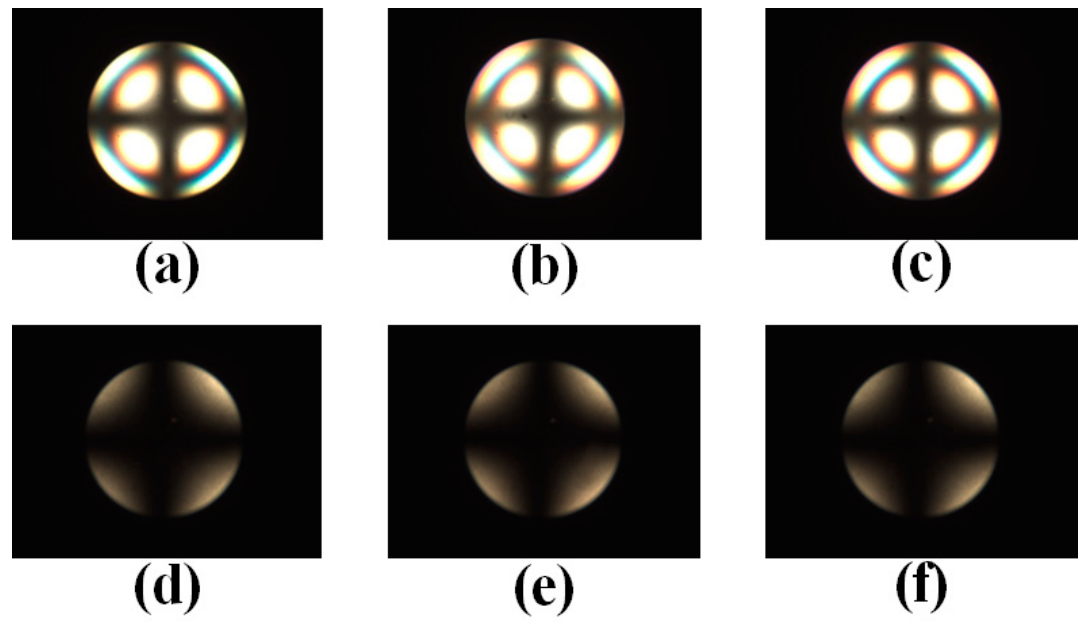
Figure 7. Conoscopic POM images of the LC cells made PBHB# films, after thermal treatment at 100, 150, and 200 °C for 10 min and UV treatment at 5, 10, and 15 J/cm 2 , respectively.